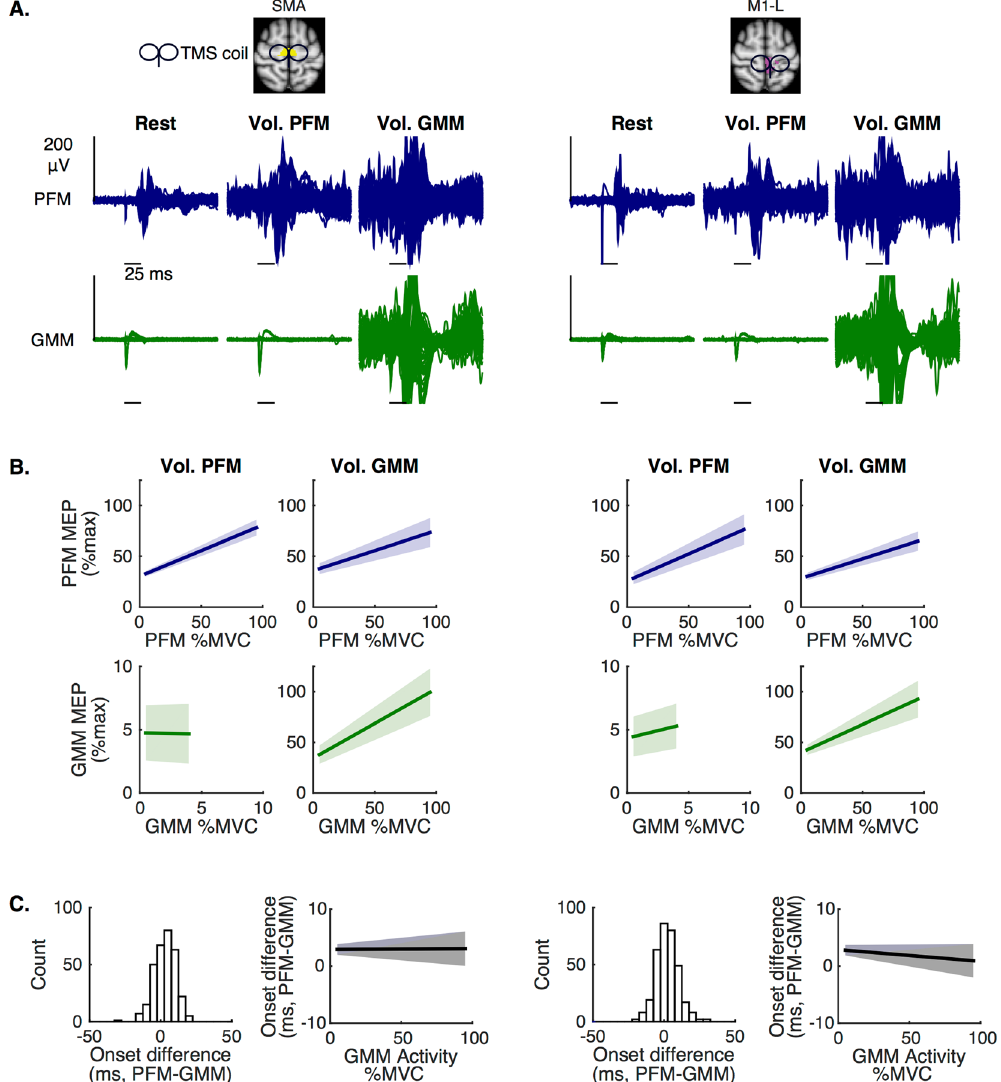
Figure 4. Transcranial magnetic stimulation (TMS) evidence of increasing neural activation in human supplementary motor area (SMA) and primary motor cortex (M1) during increased voluntary drive. ( A ) Pelvic floor muscles (PFM) hotspots in SMA and M1-L were separately stimulated to test whether MEPs can be elicited in the PFM (top row) and the gluteus maximus muscle (GMM, bottom row) at rest (first column), during PFM voluntary activation (second column), and during GMM voluntary activation (third column). Plotted MEPs were limited to contraction levels ≤ 25% MVC. PFM MEPs were observed at rest and during PFM and GMM voluntary activations. However, no GMM MEPs were observed at rest or during PFM voluntary activation. GMM MEPs were only observed during GMM voluntary activation. ( B ) Population average (solid line, ± SEM) MEPs peak-to-peak values (amplitudes) from a linear mixed model with participant-level random intercepts and slopes. In both motor regions, increased PFM activation resulted in significantly increased amplitudes of PFM MEPs (PFM-SMA: p = 0.0001, PFM-M1-L: p = 0.0017). However, increasing PFM activation did not result in increasing either GMM activation level or GMM MEPs amplitudes. In both motor regions, increasing GMM activation resulted in modulating PFM activation level, as well as, in modulating amplitudes of PFM and GMM MEPs (PFM-SMA: p = 0.0076, PFM-M1-L: p = 0.0011, GMM-SMA: p = 0.0052, GMM-M1-L: p = 0.009). ( C ) Distribution of the difference between onset latency of PFM MEPs and onset latency of corresponding GMM MEPs during GMM voluntary activation. Using linear mixed model with participant-level random intercepts and slopes showed that increasing GMM activation was not associated with changes in the difference (latency of PFM MEPs - latency of GMM MEPs, SMA: p = 0.9539, M1-L: p = 0.3954) that remained about + 3 ms on average and was significantly greater than zero (SMA: p = 0.0121, M1-L: p =